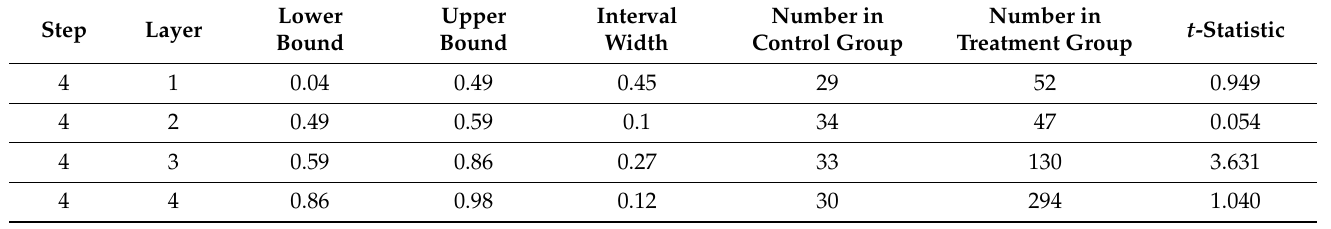
Table 7. The results of the third stratification.